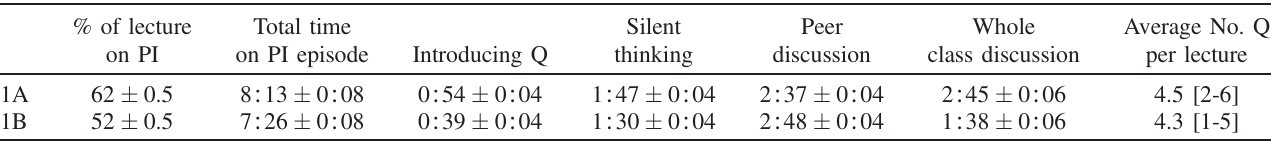
TABLE IV. Average time (in minutes) spent on different stages of PI per episode (note that not all stages of PI are included in this table). % of lecture on PI